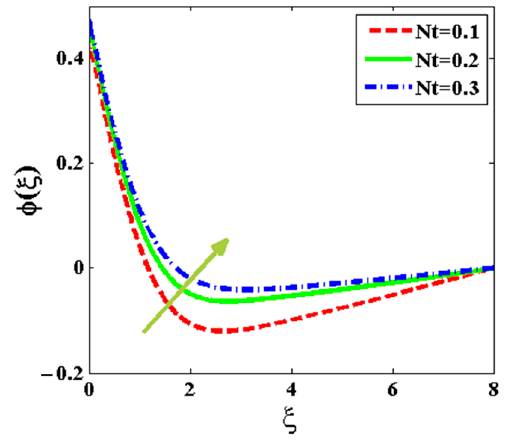
Figure 19. Outlines of 𝜙 at diverse quantities of 𝑁𝑡 .